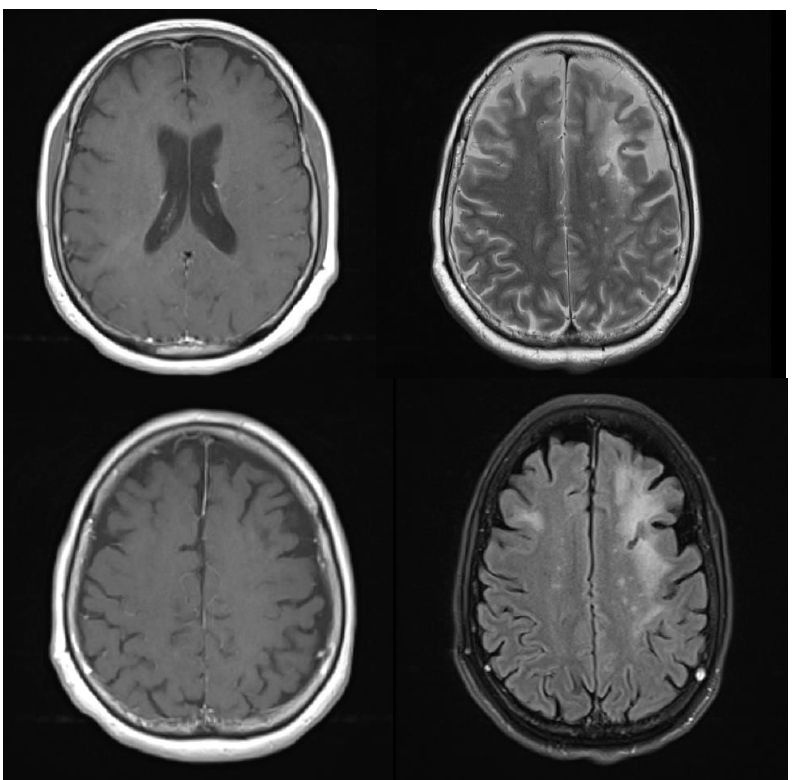
Figure 4. T2 FLAIR images of patient three months following intial presentation showing stable white matter vasogenic oedema/ T2 high signal. Multifocal enhancing foci are reduced in number, with only subtle residual punctate foci of enhancement within the left periventricular white matter.